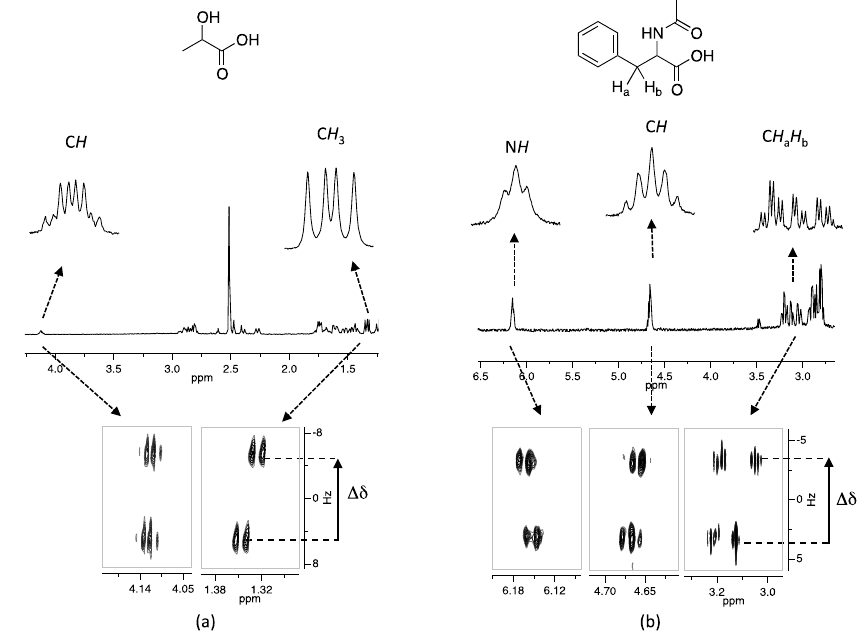
Figure 5. RES-TOCSY experiment performed on ( a ) 13a ( Δδ 11.1 Hz, CH 3 ) and ( b ) 14a ( Δδ 6.1 Hz, CH) with CSA 5 showing the resolution of R and S enantiomer in an indirect dimension.